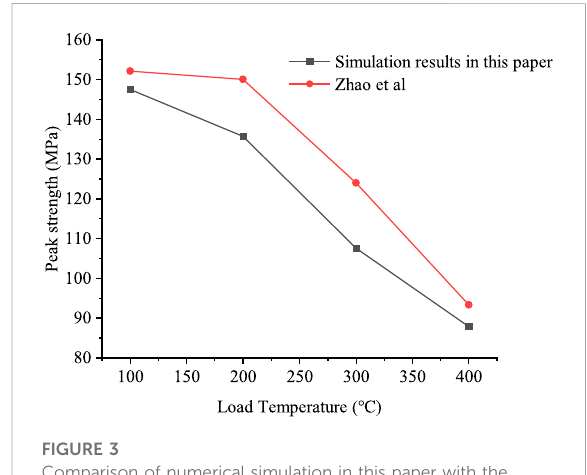
FIGURE 3 Comparison of numerical simulation in this paper with the numerical results of Zhao et al. [33].